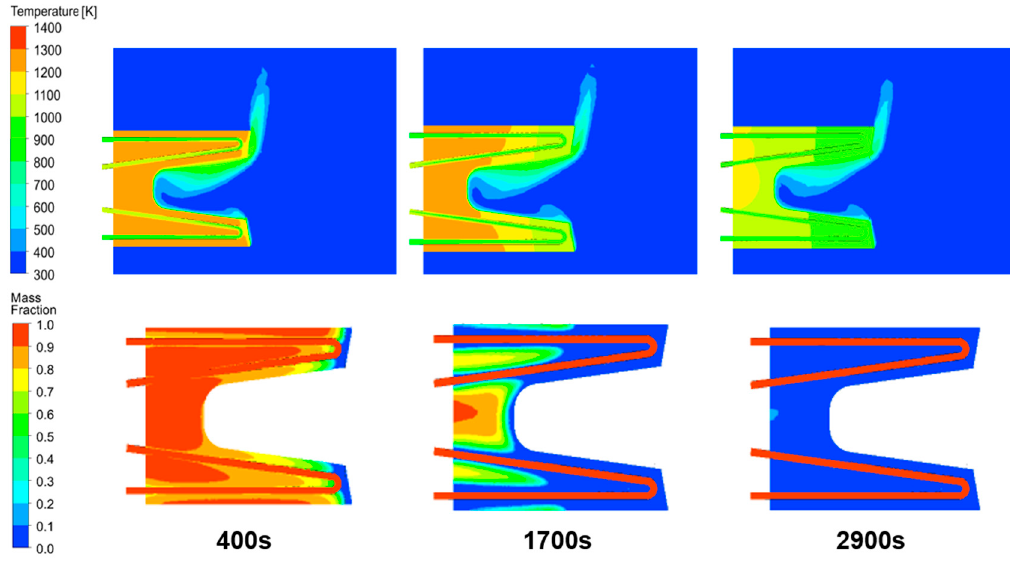
Figure. 7. Contours of temperature and PCM liquid fraction during the discharge process.